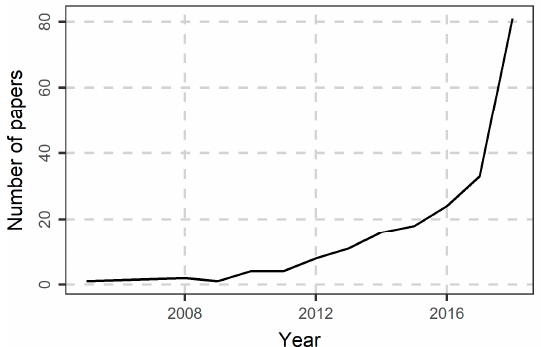
Figure2. Totalnumberofarticlesimplementingrandomforests, ortheirvariants,